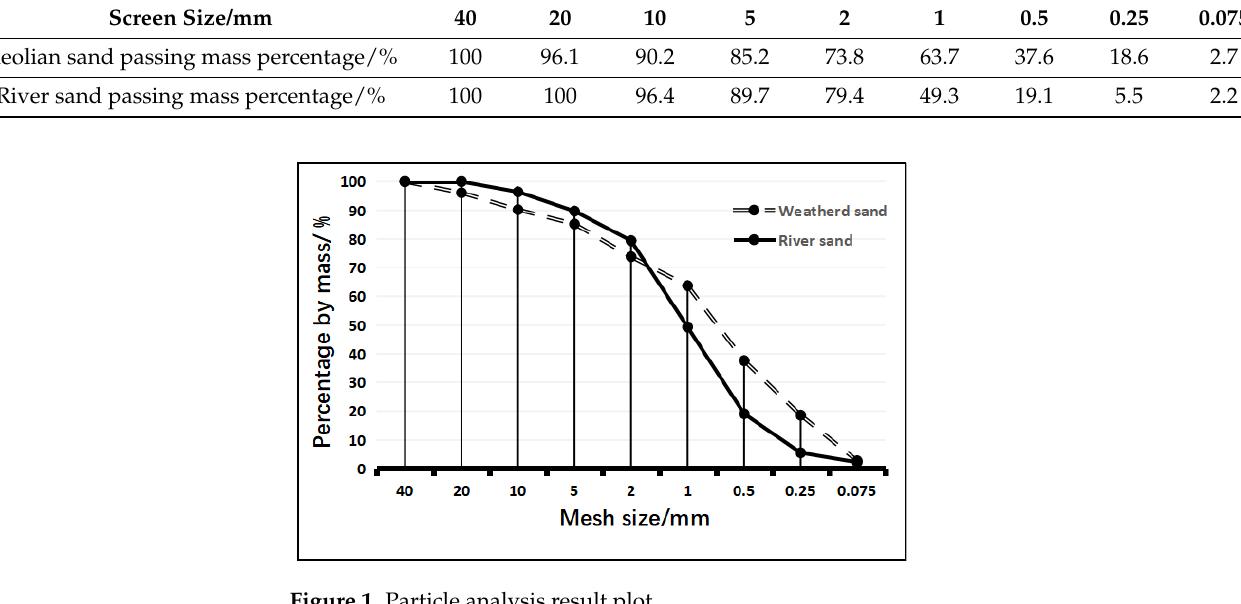
Table 2. Particle analysis results .